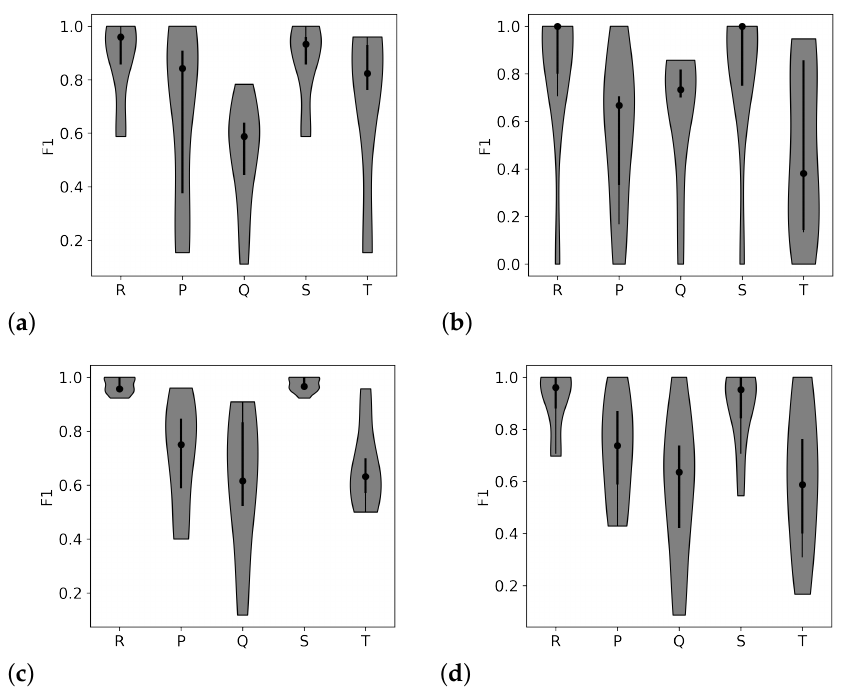
Figure 4. Each plot shows the F1 metric (the harmonic mean of precision and recall) for the four different weave structures with silver threads, tested with all participants. The x-axis labels the peak within the ECG waveform. The dot shows the median value, the black line shows the interquartile range, and the shaded area shows the shape of the distribution of scores. Higher median values and tighter distributions indicate better performance. The patterns shown are as follows, starting from the upper left corner and continuing clockwise: ( a ) sateen, ( b ) broken twill, ( c ) twill, and ( d ) birdseye. The twill pattern with medium anchoring showed the highest performance for R peak detection and the detection of the smaller